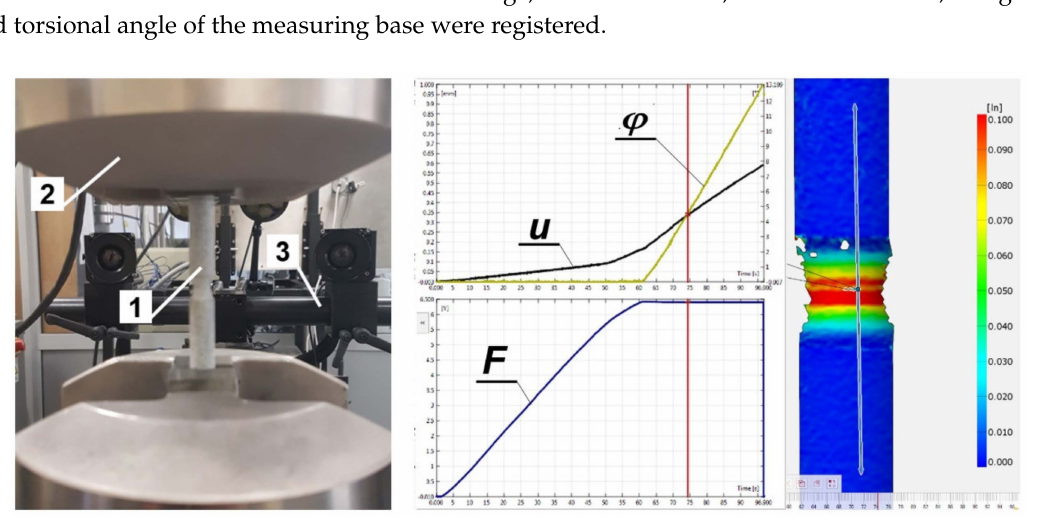
Figure 7. Specimen with notch of radius r K = 8 mm with markers (1—Specimen, 2—Hydraulic grip, 3—DIC ARAMIS 3D 4M), vision system dialogue DIC ARAMIS 3D